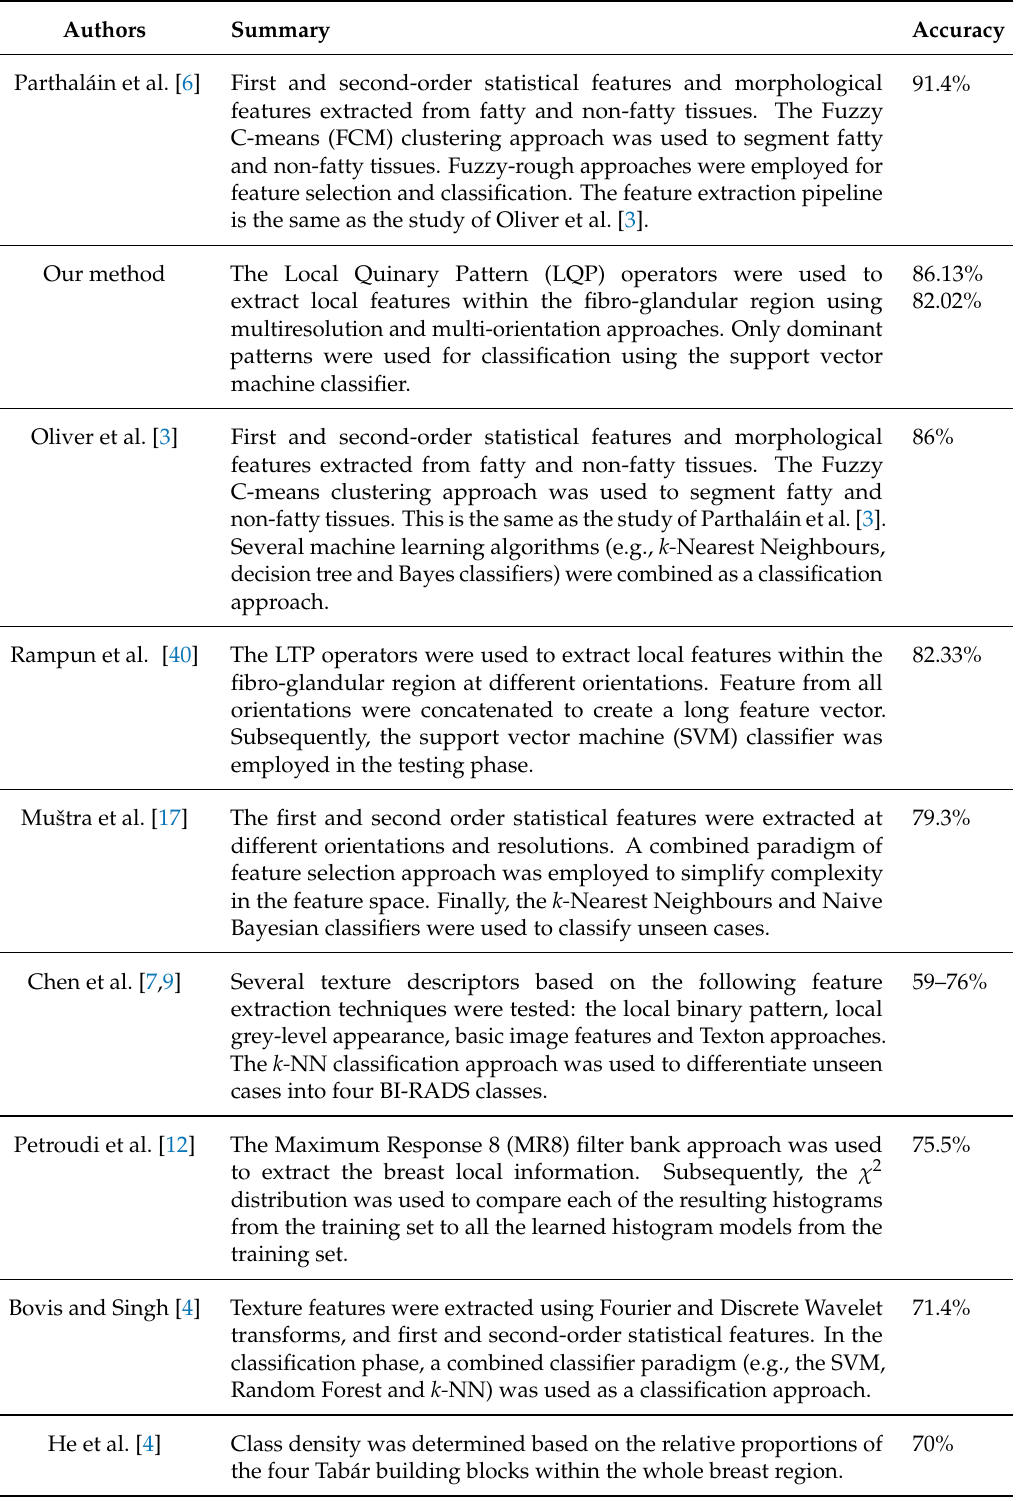
Table 6. Quantitative comparison of the current studies in the